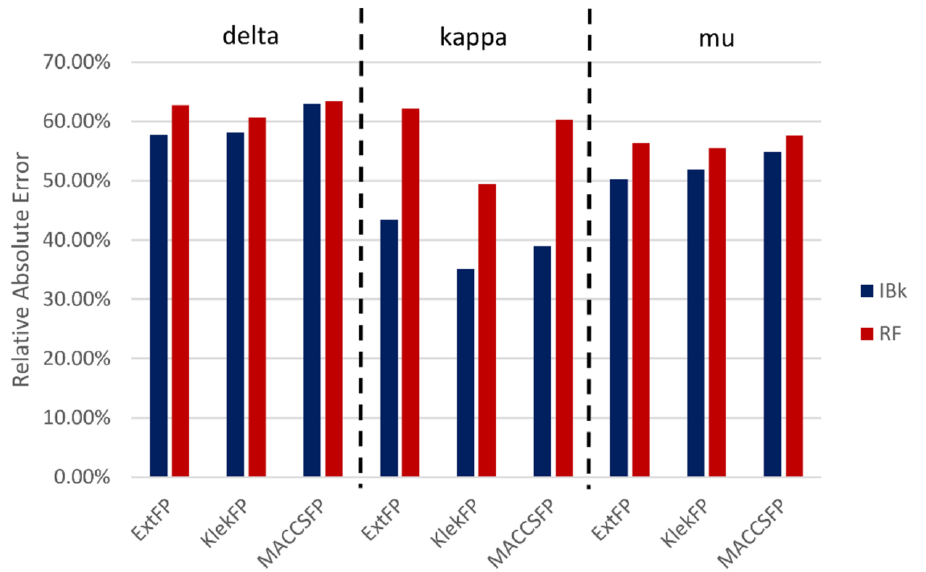
Figure 2. Relative absolute errors were obtained in the predictions of compounds K i values for different machine learning (ML) algorithms and compound representations.